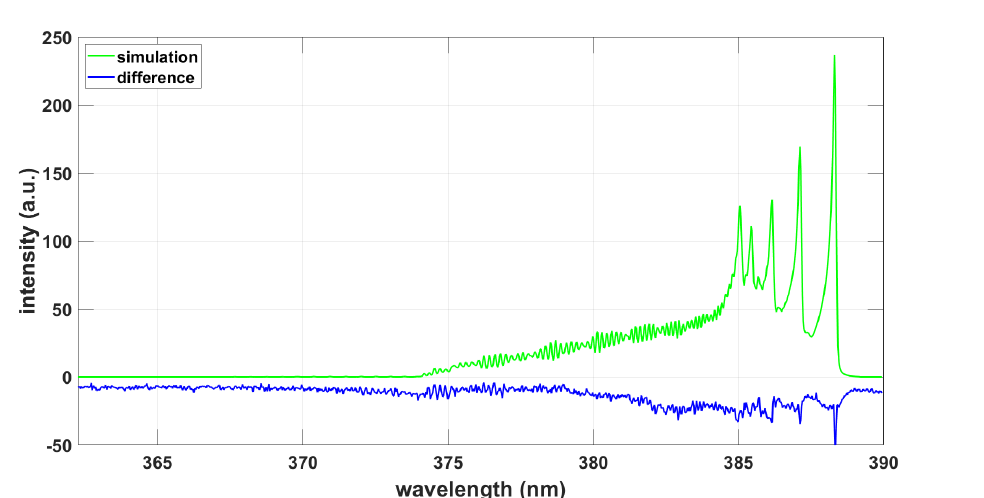
Figure 10. Simulation using LIFBASE with fixed T = 8340 K, ∆ λ = 0.11 nm, Voigt profile with 30% Lorentzian